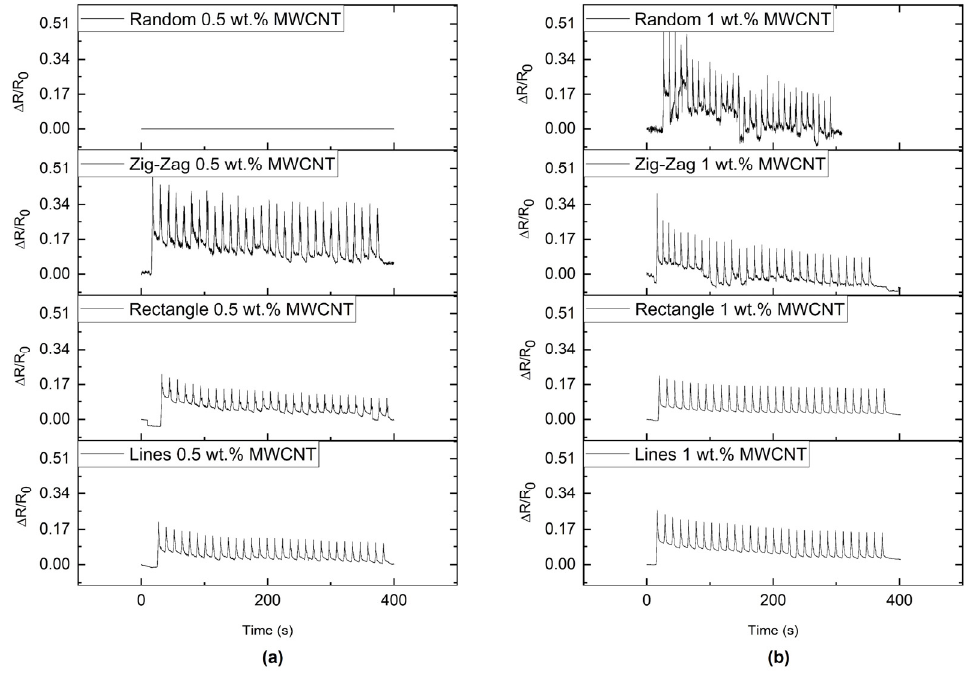
Figure 12. Piezoresistive effect for samples with ( a ) 0.5 and ( b ) 1 wt.% of MWCNTs with different magnetic patterns, from top to bottom: random, zig-zag, rectangular and parallel lines.